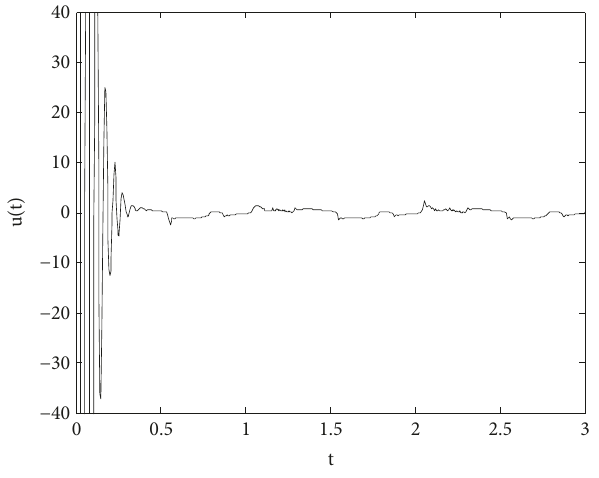
Figure 5: State response of control input.